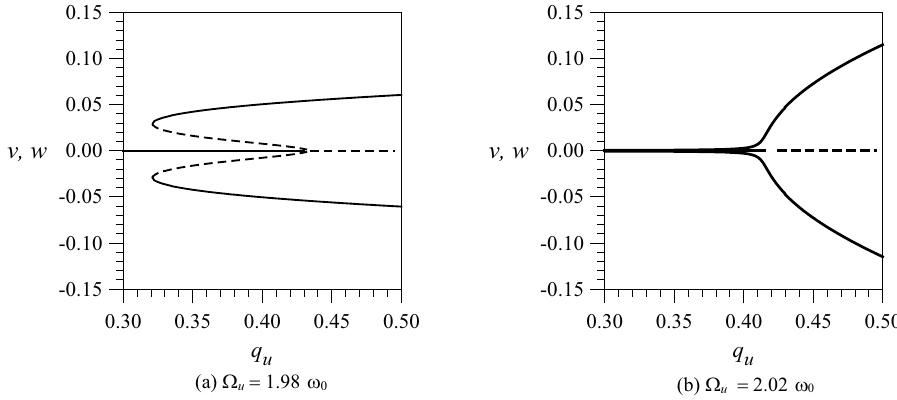
Fig. 14. Characteristic bifurcation diagrams in the principal parametric instability region. P s /P cr = 10.35 (case 3).